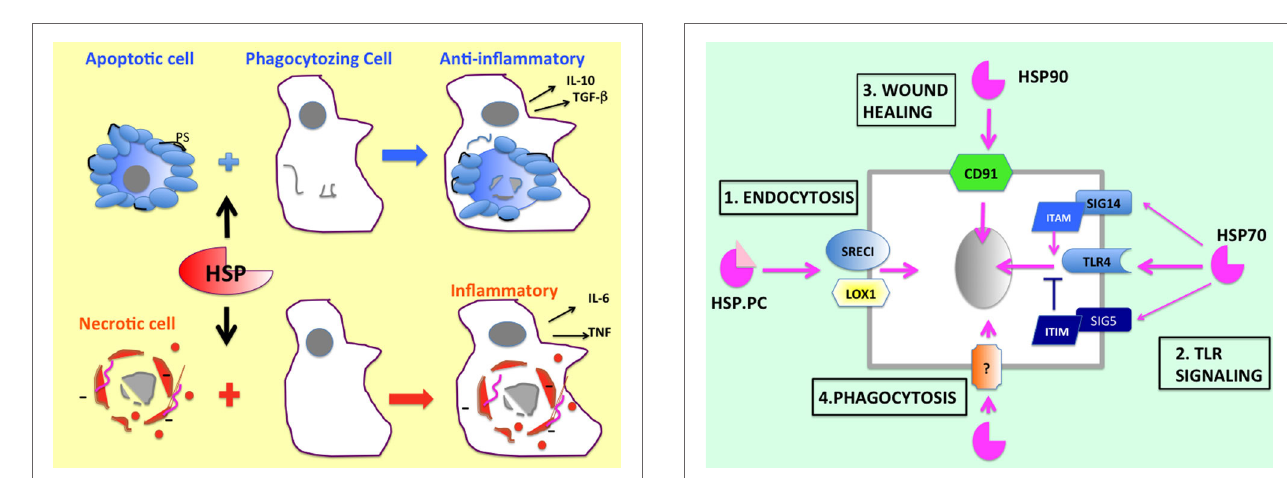
FiGURe 3 | HSP receptors . HSP receptors include SREC-I and LOX-1 that mediate (1) endocytosis and, thus, presentation of antigens to APC. Hsp70 can also (2) trigger signaling through the TLR4 pathway in a range of cells. (It is not clear whether HSPs can interact directly with TLRs or whether the primary interactions are through other receptors.) Effects of Hsp70 on TLR4 signaling can be modulated by binding to either Siglec-14 that activates TLR4 signaling or other Siglec family members, such as Siglec-5, that activate the pathway. Hsp90 can also (3) activate wound healing responses, which may play key roles in inflammation, through binding to CD91. Hsp70 triggers (4) phagocytosis, a property that may be important in its immune functions, through currently unknown mechanisms. Gray ovals indicate nuclei.